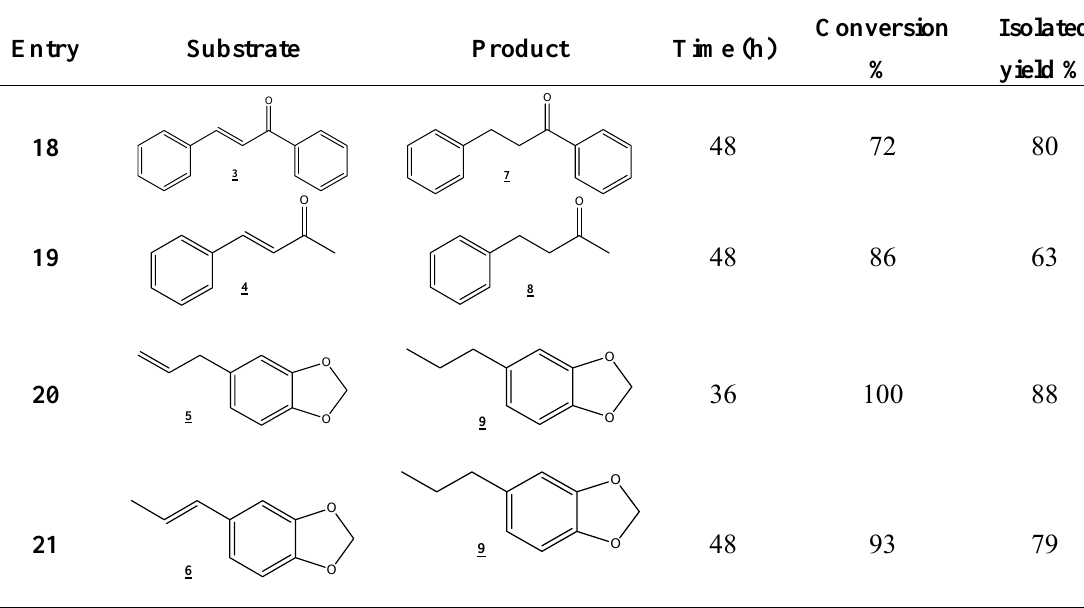
Table 3. Hydrogenation of olefins catalyzed by Ni(0)-CMC-Na